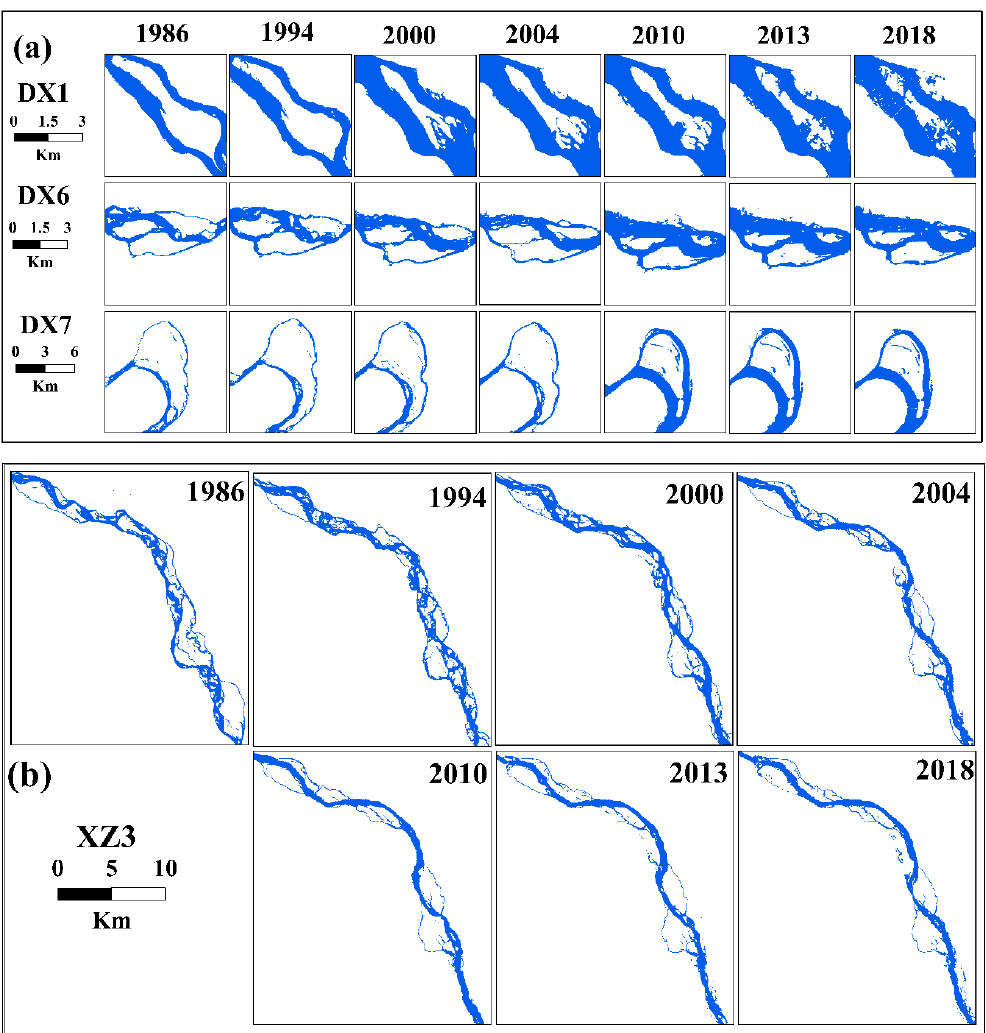
Figure 4. Channel bars with obvious changes in area during 1986–2018.